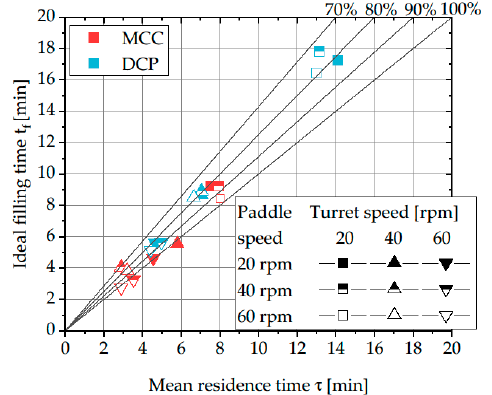
Figure 5. Comparison of mean residence time and ideal filling time for MCC and DCP using the rotary tablet press XL 100 and different levels of turret and paddle speed. Plotted lines represent different theoretical filling levels of the feed frame.